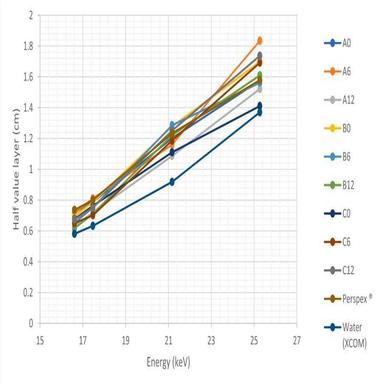
The half value layer calculated for the Rhizophora spp. samples, Perspex ® and XCOM of water against low energies.